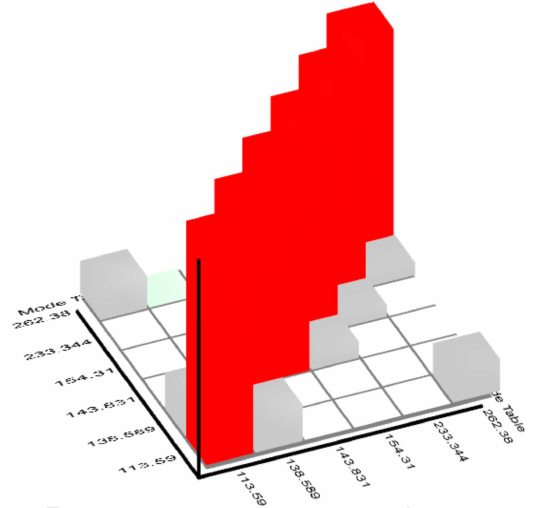
Figure 5. Spindle rotor mac matrix.